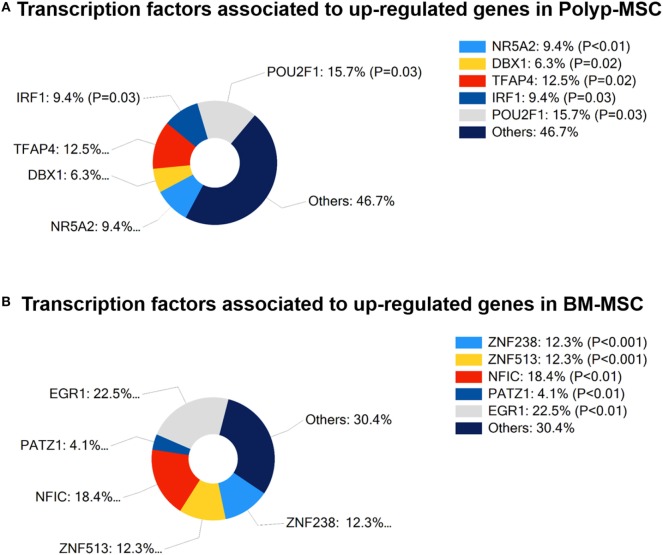
Transcription factors associated with differentially modulated genes in Polyp-MSCs (PO-MSCs) and in bone marrow-derived MSCs (BM-MSCs). (A) Percentage of participation of transcriptional regulators in upregulated genes in PO-MSCs. (B) Contribution (%) of main transcriptional regulators associated with upregulated genes in BM-MSCs. It is possible to observe that the transcription factors most often associated with modulated genes in PO-MSC were POU2F1 (15.7%, p = 0.03) and TFAP4 (12.5%, p = 0.02), while EGR-1 (22.5%, p < 0.01) and NFIC (18.4, p < 0.01) were predicted as main transcriptional regulators in BM-MSC.